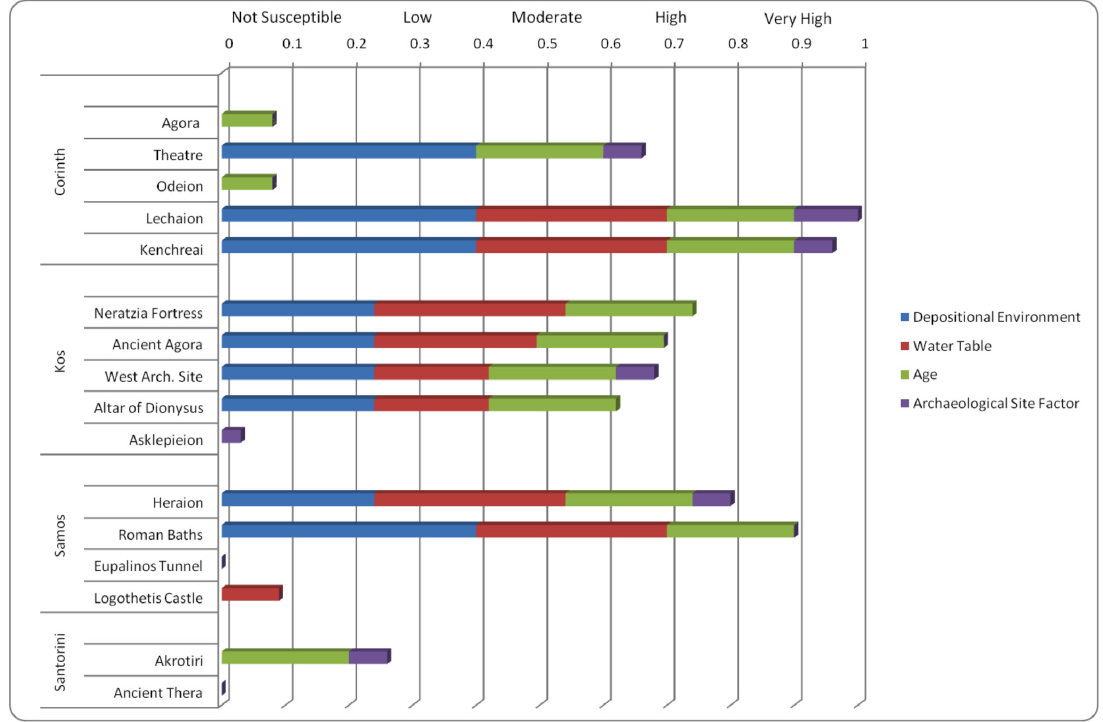
Figure 3. The Liquefaction Susceptibility indicator diagram for the archaeological sites under study.